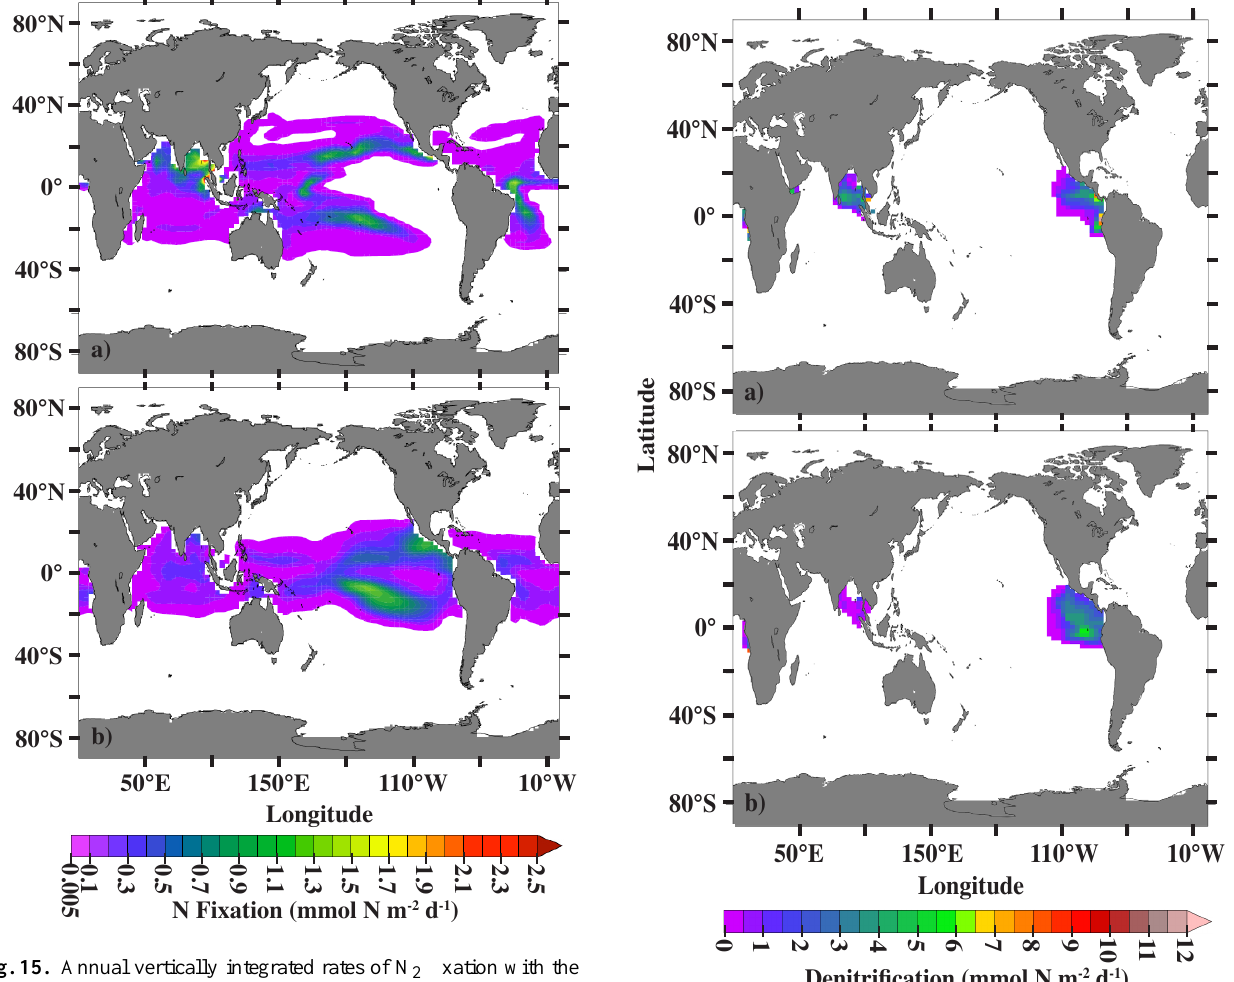
Fig. 15. Annual vertically integrated rates of N 2 fixation with the (a) new and (b) old model formulations.